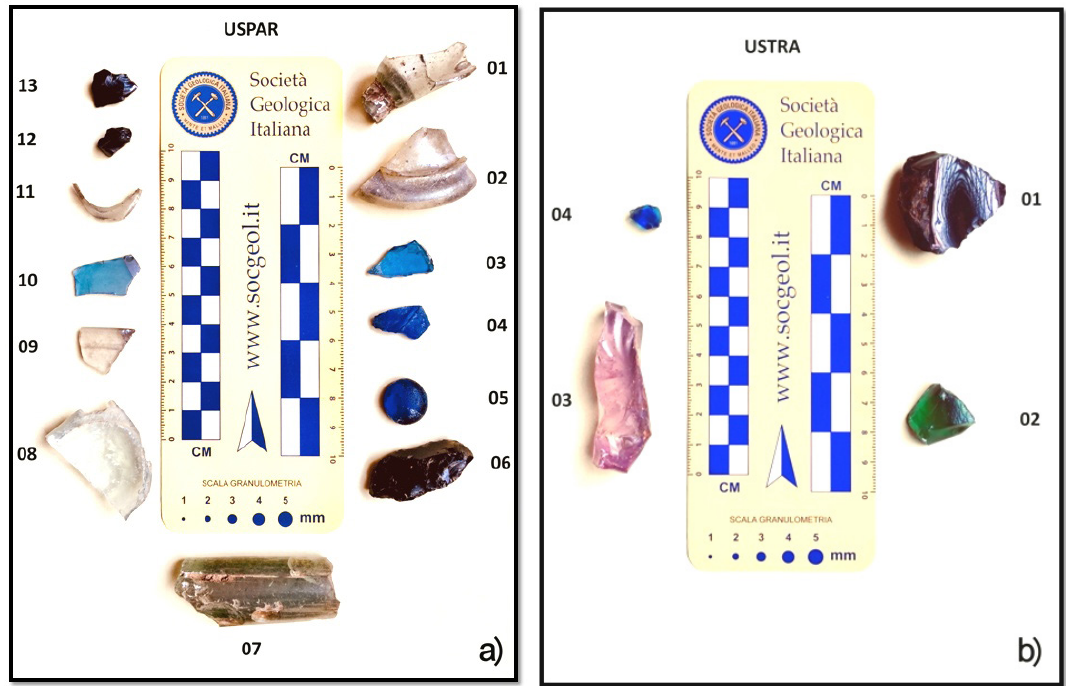
Figure 2: The two assemblages of glass fragments examined in this study: a) USPAR-01-13; b) USTRA-01-04.